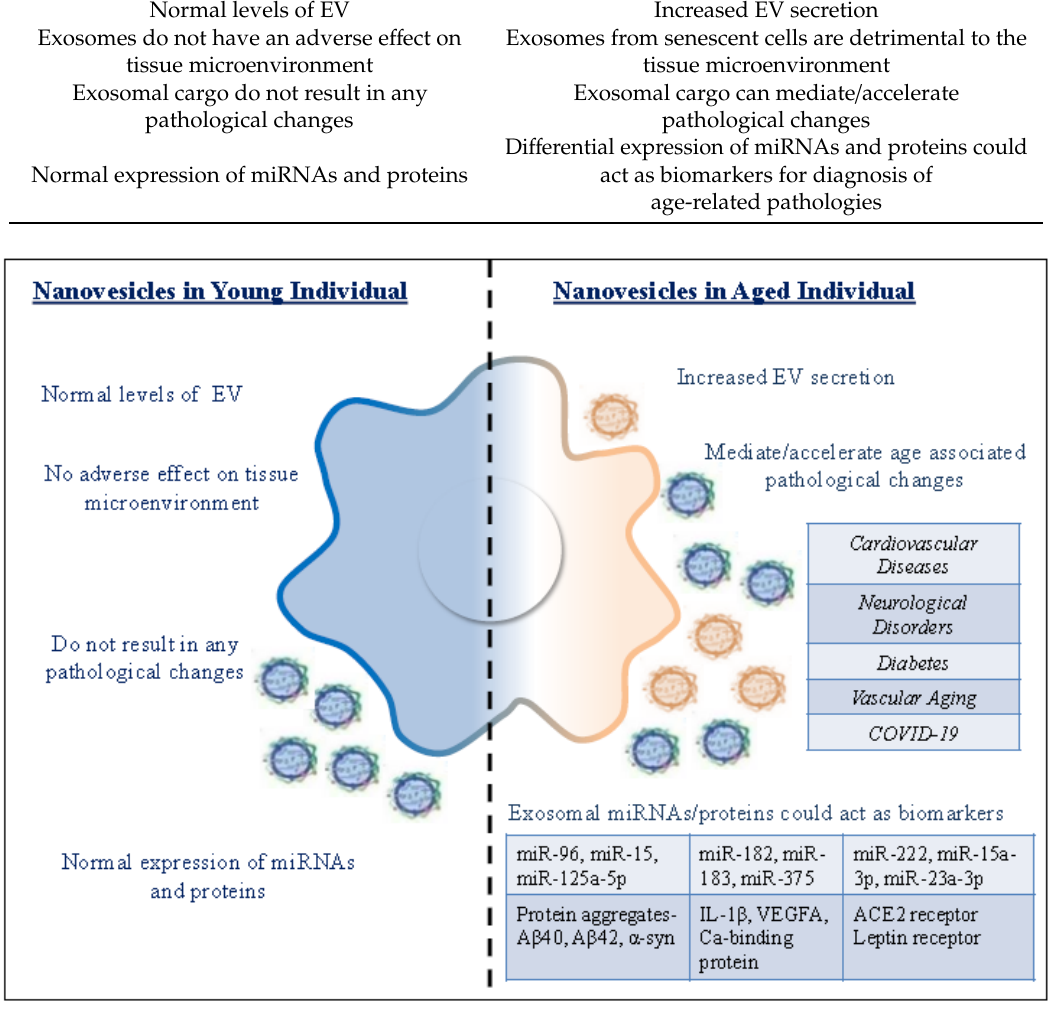
Figure 3. Graphical representation of the age-associated characteristics of nanovesicles.